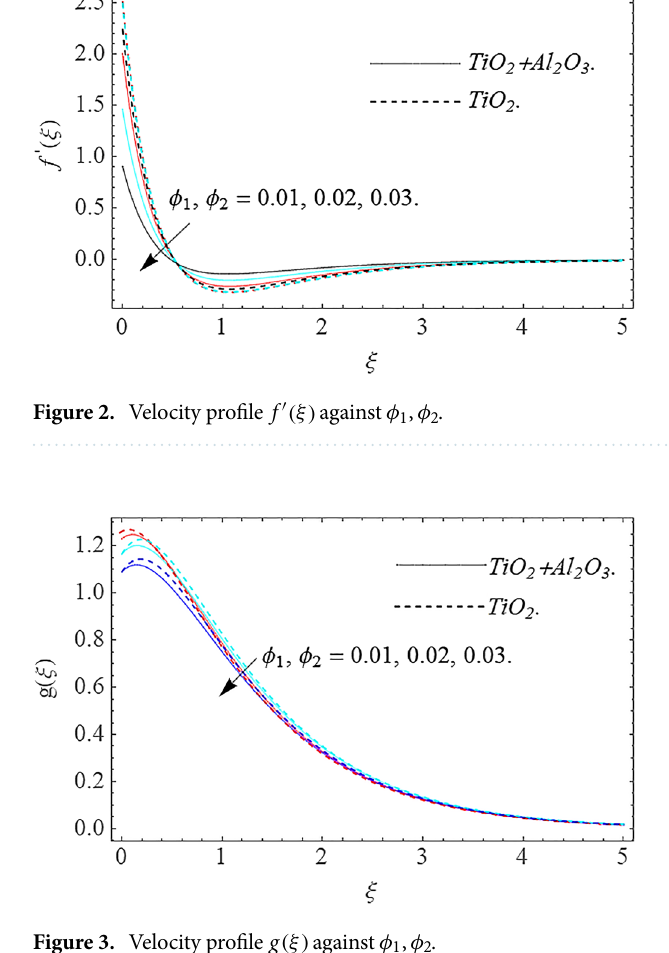
Figure 3. Velocity profile g (ξ) against φ 1 , φ 2 .